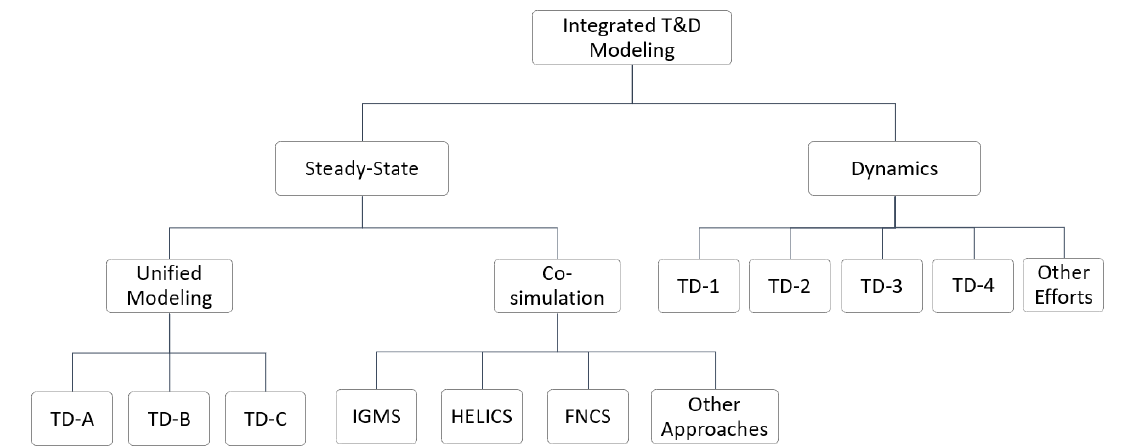
Figure 1. Hierarchy of the major integrated transmission-and-distribution (T&D) modeling topics discussed in this paper.